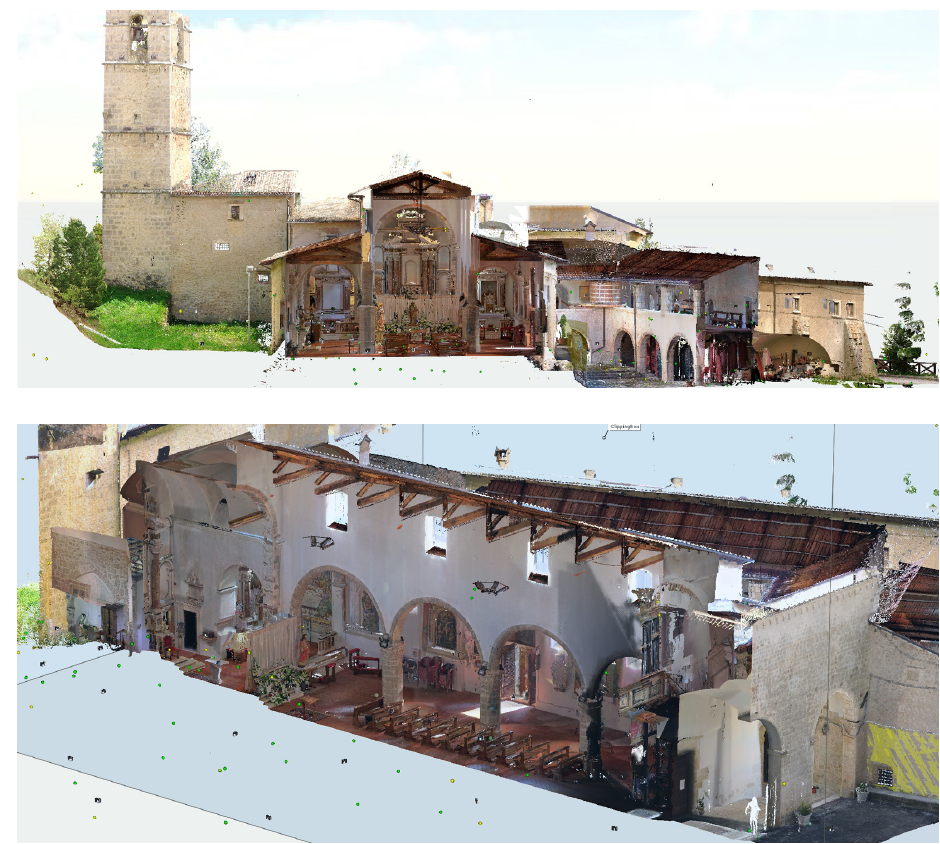
Fig. 2 Exploring the point cloud. Fig. 3 Surfing between raw